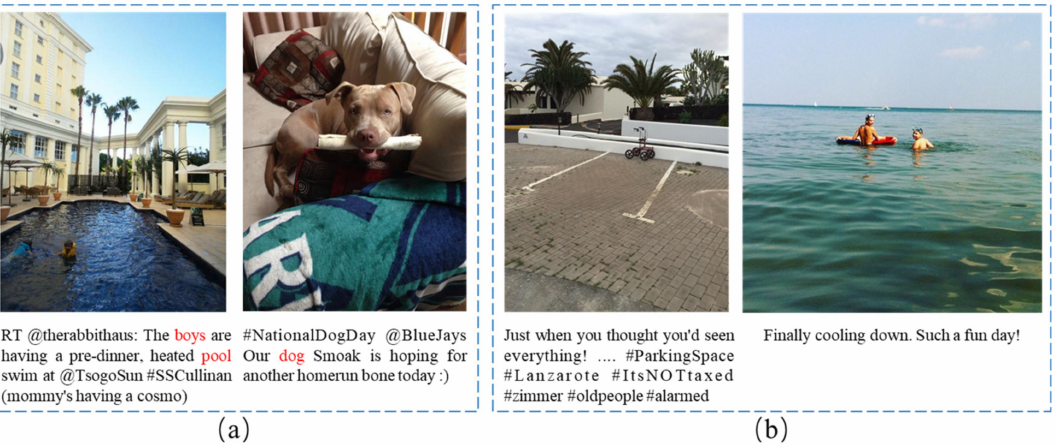
Figure 1. Examples of image–text posts from Twitter. ( a ) shows the fine-grained relation between image and text. ( b ) shows the global relation between image and text.